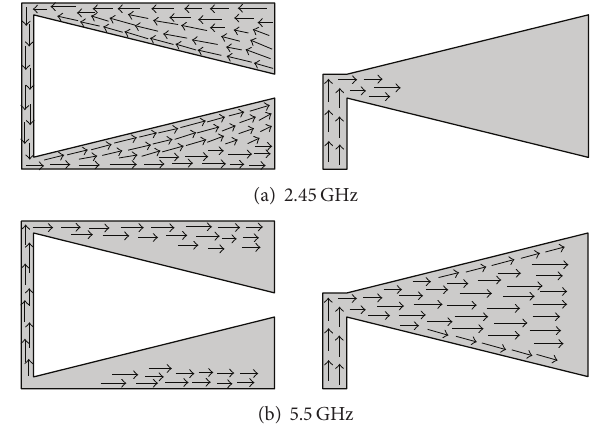
Figure3:Simulatedsurfaceelectricalcurrentdistributionsobtained at (a) 2.45 and (b) 5.5 GHz for proposed